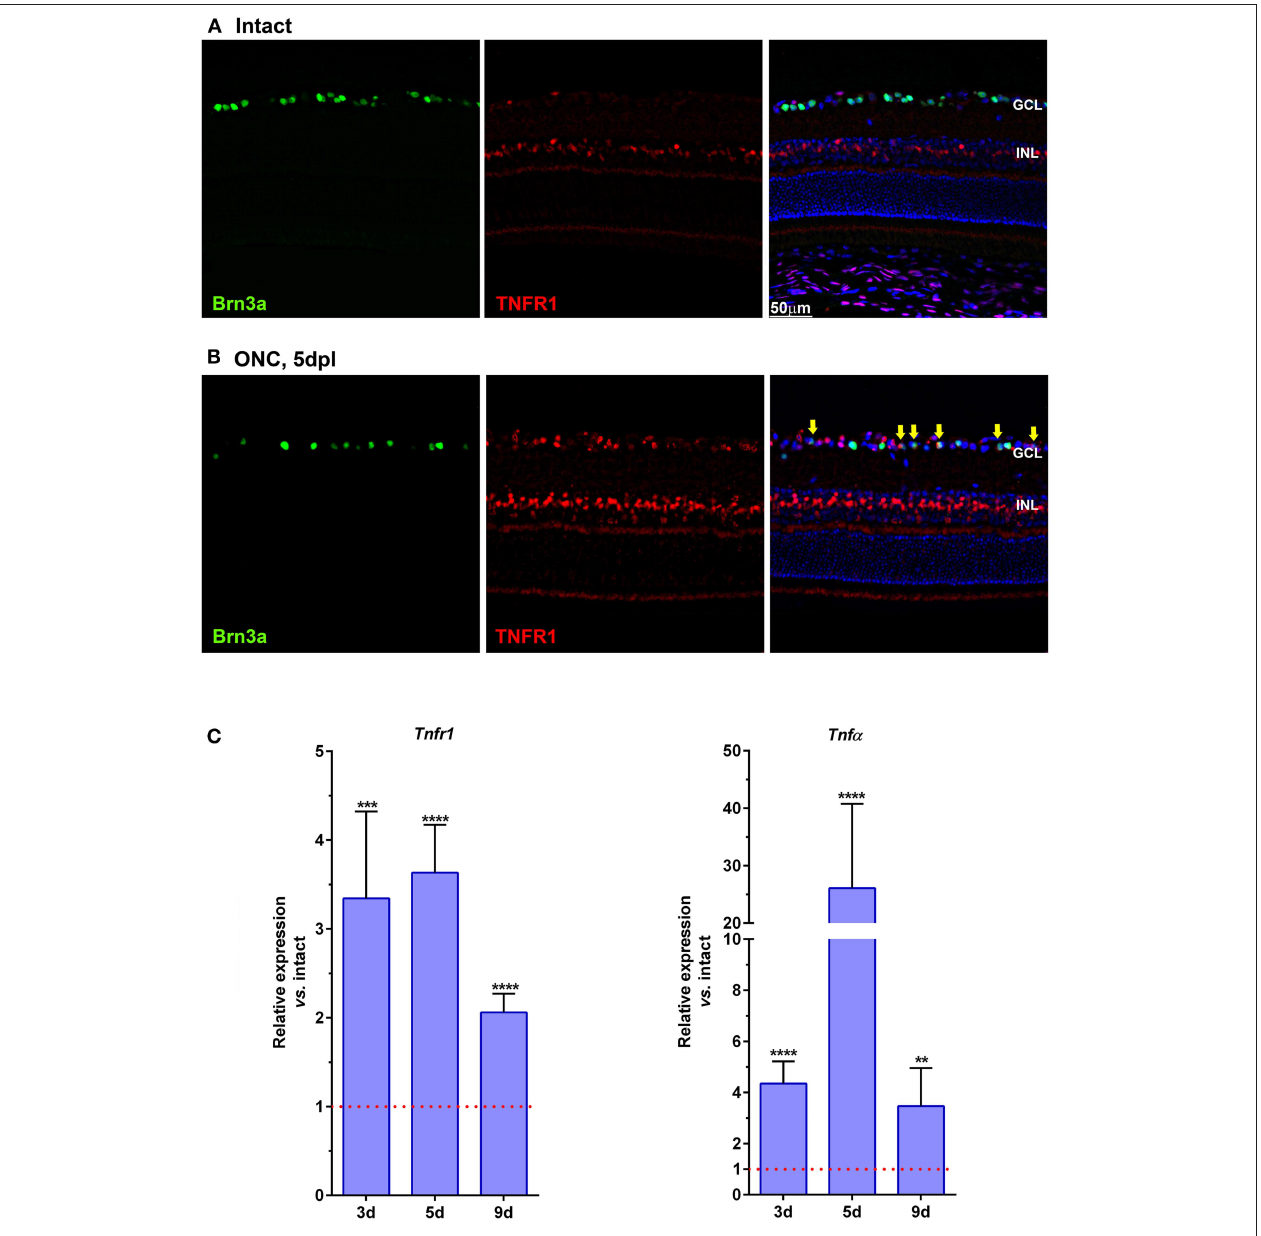
FIGURE 2 | TNFR1 is over-expressed in the retina after ONC. (A,B) Magnifications from retinal cross-sections showing the double immunodetection of Brn3a (green), TNFR1 (red), and the merged image with DAPI. In intact retinas (A) TNFR1 expression is observed mainly in the inner nuclear layer (INL), and in few Brn3a negative cells in the ganglion cell layer (GCL). Five days after ONC (B) many cells in the GCL, including RGCs (yellow arrows) express TNFR1. (C) Graph bars showing the fold change ± SEM of Tnfr1 and TNF α mRNA levels in ONC-injured retinas relative to intact retinas (value 1, red dotted line; ** p < 0.01; *** p < 0.001; **** p < 0.0001, T -test vs. naive). d, days